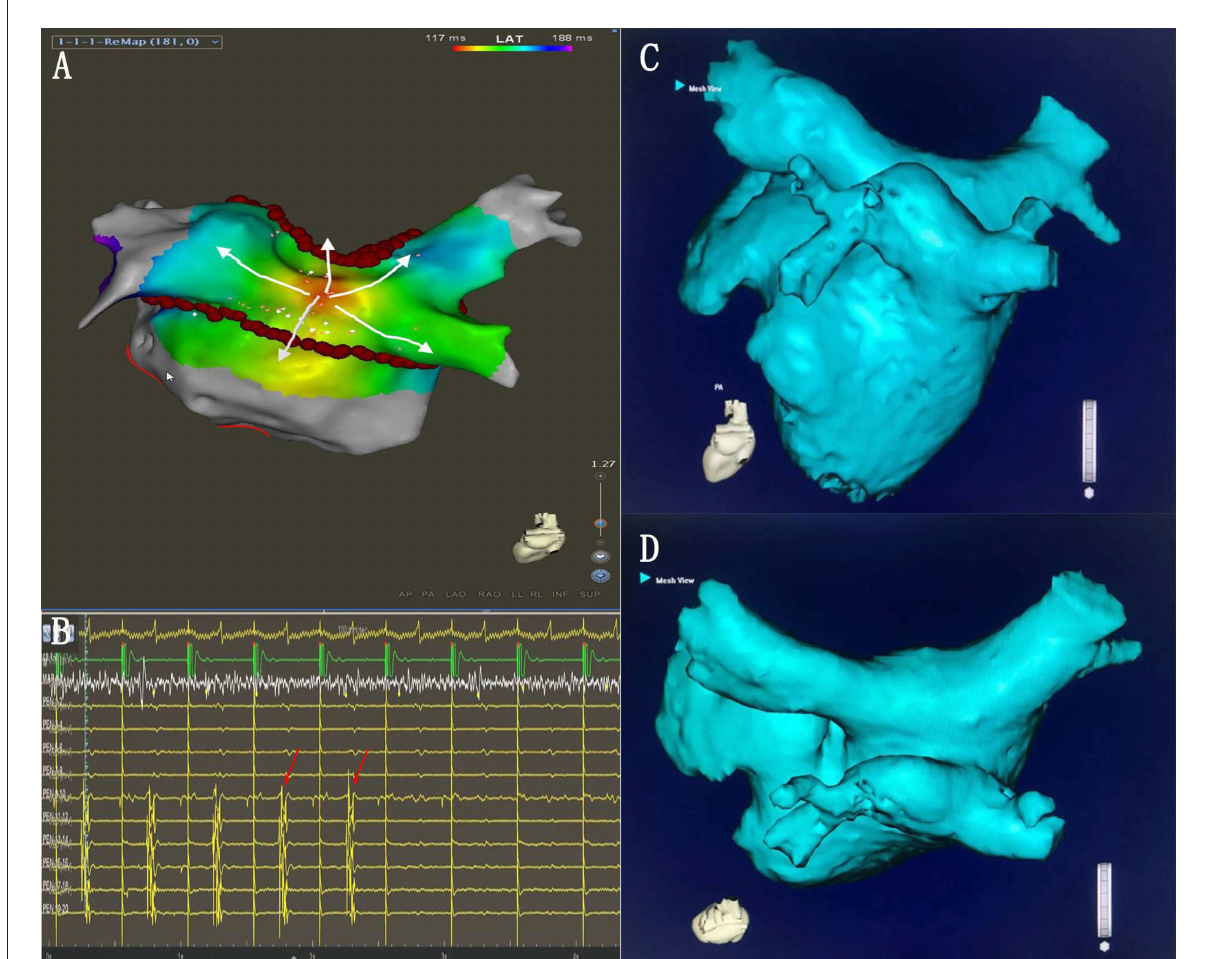
FIGURE7 (A) Activation mapping under the CS pacing. The earliest activation site was located on the LAPW (white arrows). (B) During the additional ablation at the LAPW earliest activation point, the potential disappeared. (C,D) The common ostium of inferior pulmonary veins of the anatomical